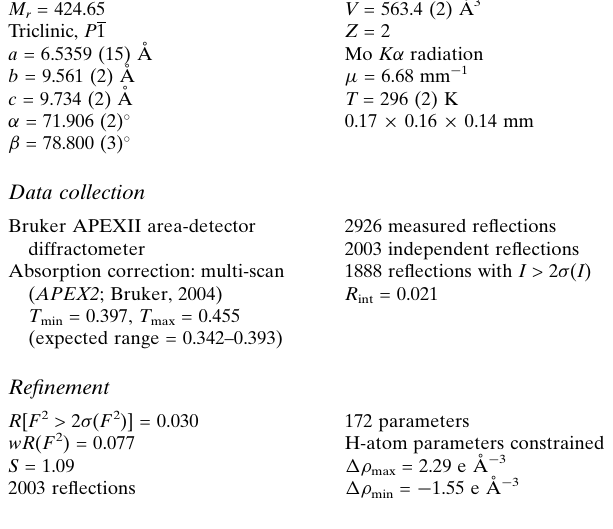
Experimental Crystal data